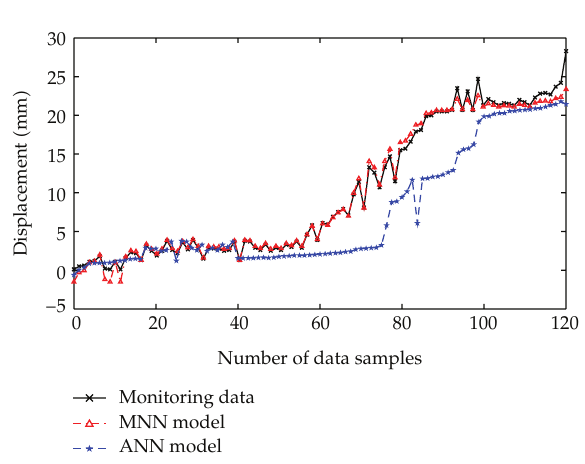
Figure 9: Displacement forecast